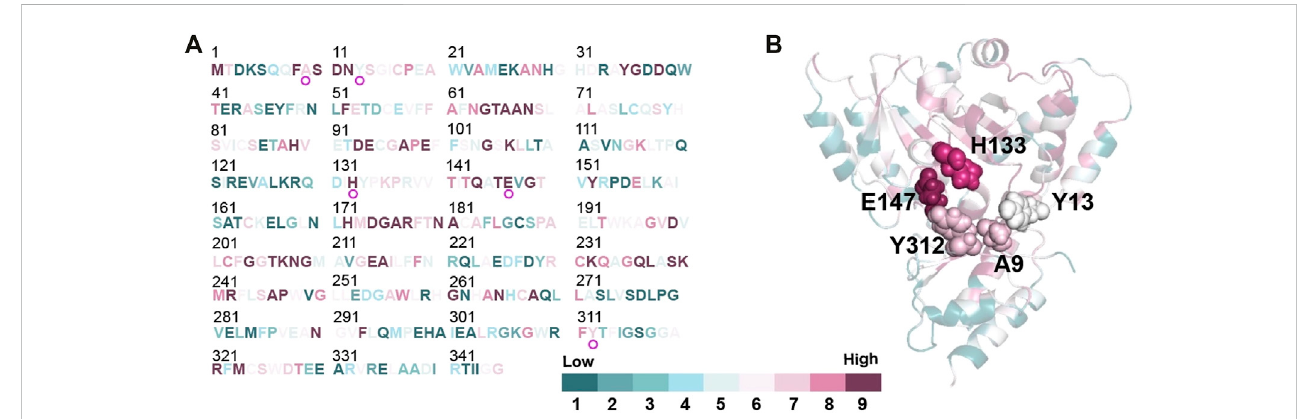
FIGURE 7 Conservation analysis of L -PpTA by ConSurf (https://consurf.tau.ac.il/). Amino acids are colored by their conservation grades. (A) Conservation of each aminoacidsresidueintheproteinsequence; (B) Theproteinstructureofthemonomerrepresentedasacartoon.A9,Y13,H133,E147,andY312arehighlighted by spheres.